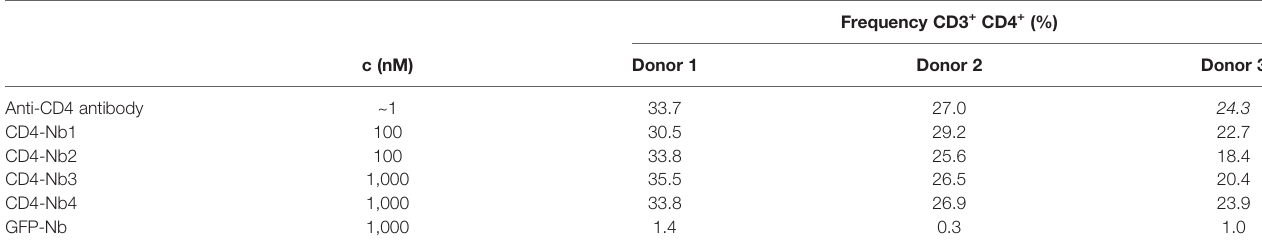
TABLE 2 | Percentage of double-positive cells of three donors, stained with CD4-Nb1 or CD4-Nb2 (100 nM), or CD4-Nb3 or CD4-Nb4 (1,000 nM), compared to anti- CD4 antibody and negative control Nb (GFP-Nb, 1,000 nM).